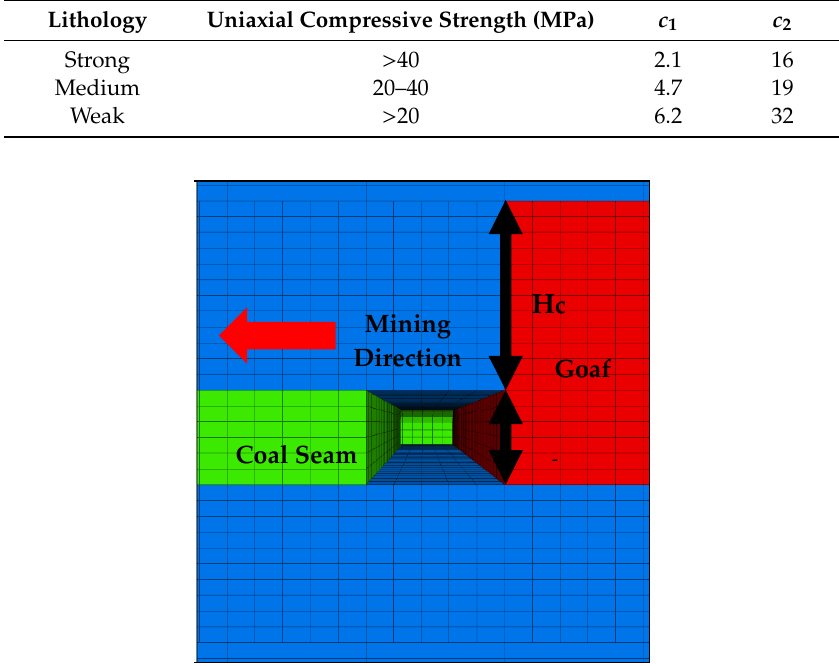
Figure 6. Goaf modeling during panel extraction.